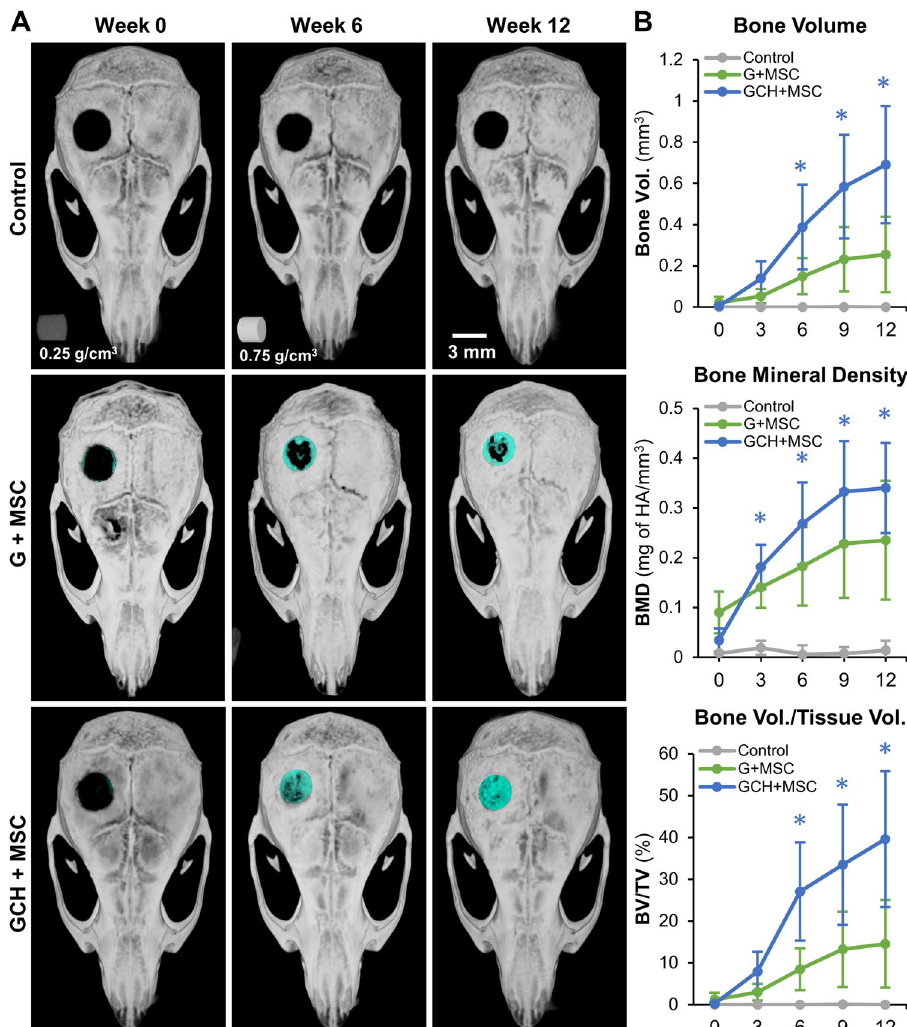
Figure 10. Murine critical-sized calvarial defect. ( A ) 3D reconstructed microCT images of the mice crania over time, showing the defect being bridged. Control (CNT) animals received acellular fibrin carrier gel, the second group received gelatin microgels seeded with MSC, and the last group received gelatin microgels with HA seeded with MSC. ( B ) Bone morphometric analysis of the newly formed bone shows a steady increase in new bone volume and mineral density (BMD) in conditions containing MSC-seeded microgels. n = 4 for each